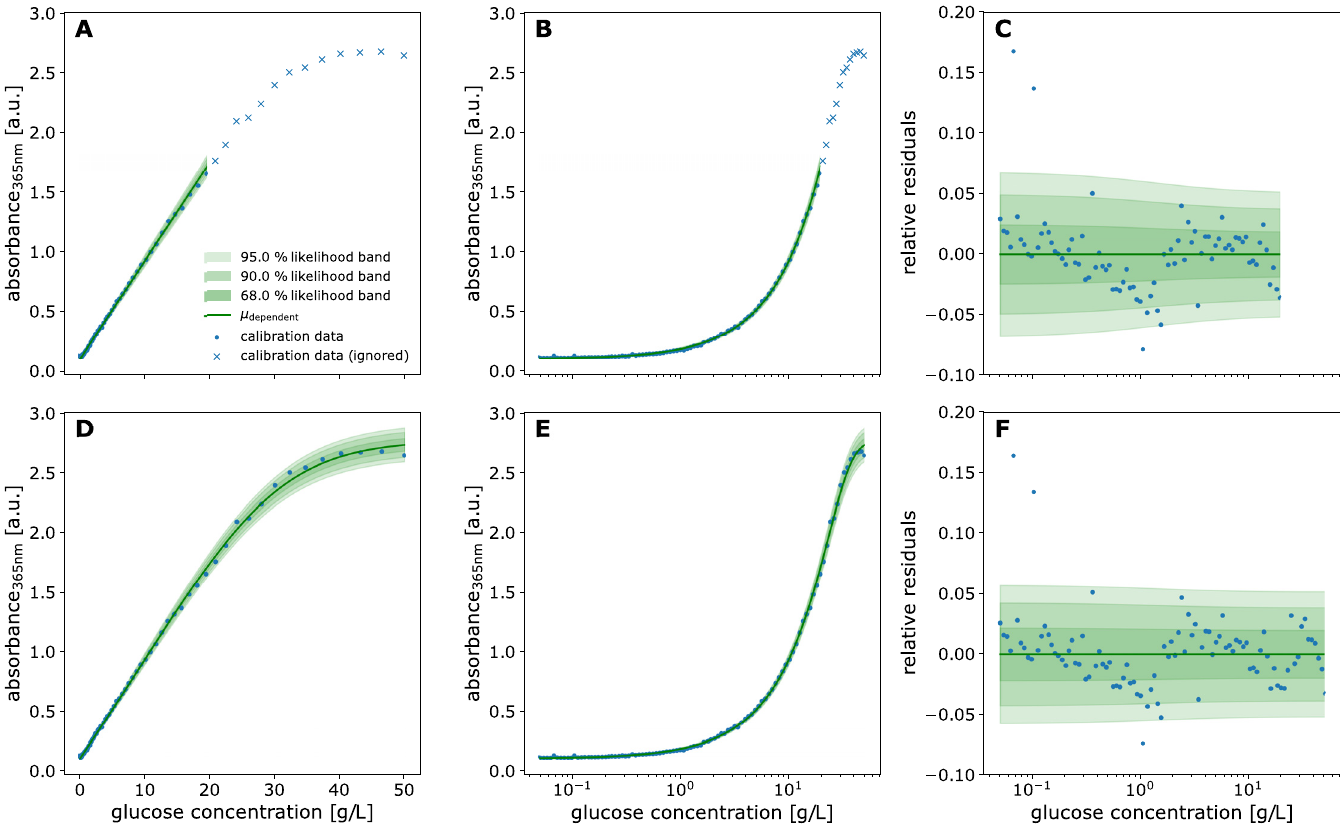
Fig 8. Linear (top) and logistic (bottom) calibration model of glucose assay. A calibration model comprising linear functions for both the location parameter μ A365 and the scale parameter of a Student- t distribution was fitted to calibration data of glucose standard concentrations ( 0 : 05 (cid:0) 20 g ) and absorbance readouts by maximum L likelihood estimation ( A-C ). The calibration data used to fit the linear model is the 0 : 05 (cid:0) 20 g subset of standards that were spaced evenly on a log-scale up to 50 g ( B, L L E ). Likewise, a calibration model with a 5-parameter asymmetric logistic function for the μ parameter of the Student- t distribution was fitted to the full 0 : 05 (cid:0) 50 g L calibration dataset ( D-E ). In both models, the scale parameter was modeled as a 1st-order polynomial function of μ and the degree of freedom ν as a constant. The extended range of calibration standard concentrations up to 50 g reveals a saturation kinetic of the glucose assay ( A, D ) and depending on the glucose concentration, the L residuals ( C, F ) with respect to the modeled location parameter are scattered by approximately 5%. Modeling the scale parameter of the distribution as a 1st-order polynomial function of μ describes the broadening of the distribution at higher concentrations ( C